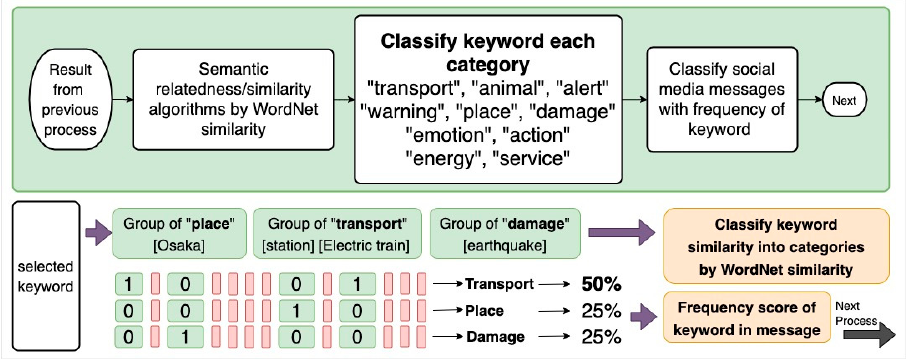
Figure 5. Classification of social media messages process.